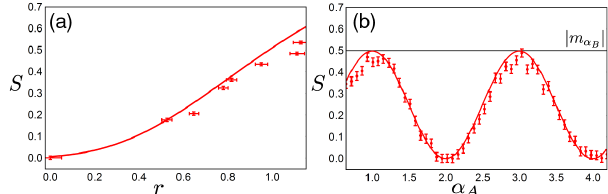
FIG. 2. Dependence of SIT of measurement A to measurement B on (a) interference and (b) geometrical phases. Solid lines show the expectations for an ideal experimental system, and the error bars of S are propagated from the shot-noise standard errors of the mean (SEM) of the directly measured probabilities P B ð b Þ , P A ð a Þ , and P B ð b j a Þ . (a) The SIT measurement settings α B ¼ 3 . 1 i , j A ˆ S α 3 . 02 ≈ 3 π = j α ð r Þj 0 i , A ¼ B j are applied to squeezed input states where the squeezed axis is aligned with position. (b) The geo- metric phase is varied by sweeping the displacement amplitude α A , and using a Schrödinger ’ s cat input A of measurement ˆ D ˆ D superposition ( ð − α B = 2 Þ þ ð α B = 2 Þ ) j 0 i with α B ¼ i π .